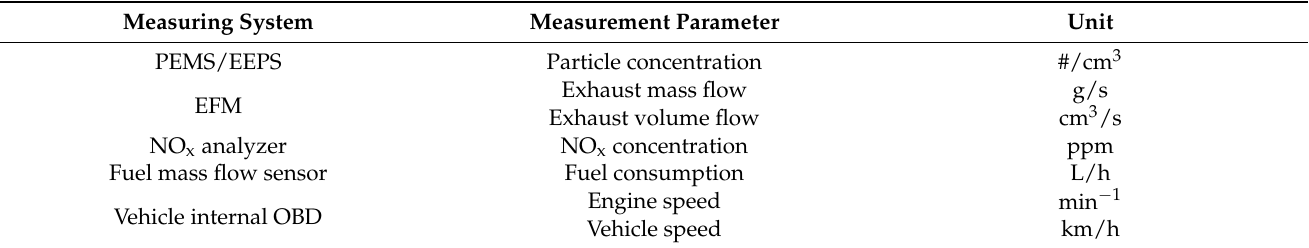
Table 2. Overview of the relevant measuring systems and measurement parameters.